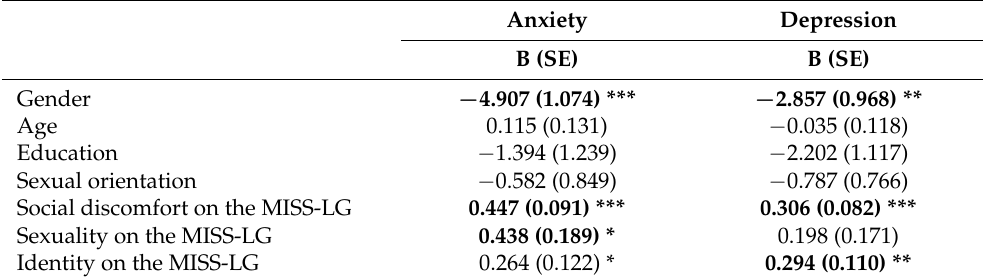
Table 4. Association of internalized sexual stigma with anxiety and depression: Multivariate linear regression analysis.